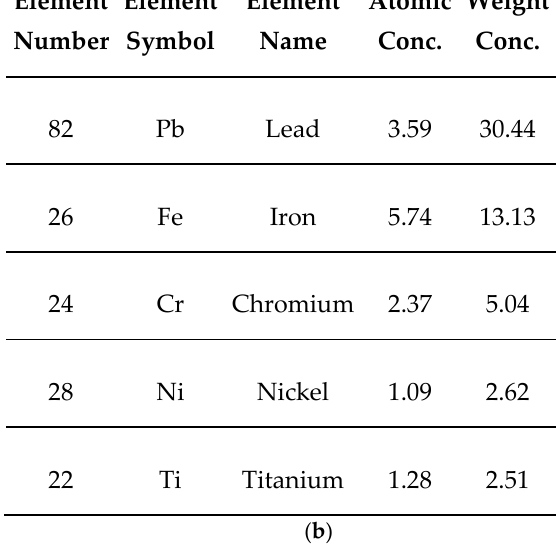
Figure 16. SEM micrograph of the edge of the bullet hole in the steel plate from the side of the